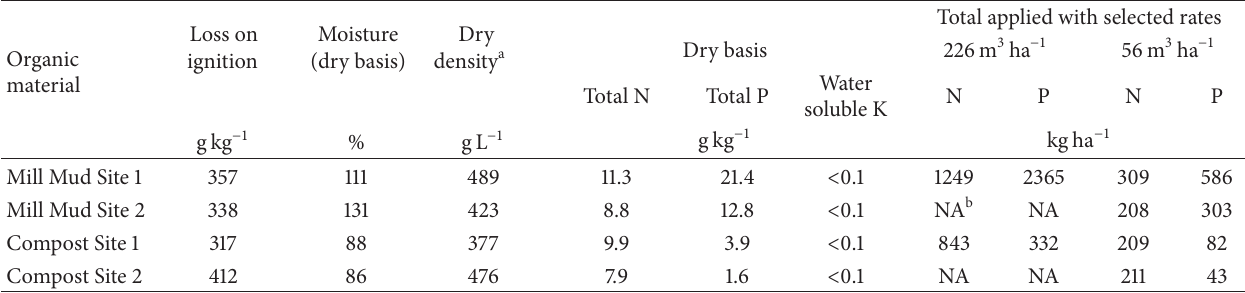
Table 1: Characterization of organic